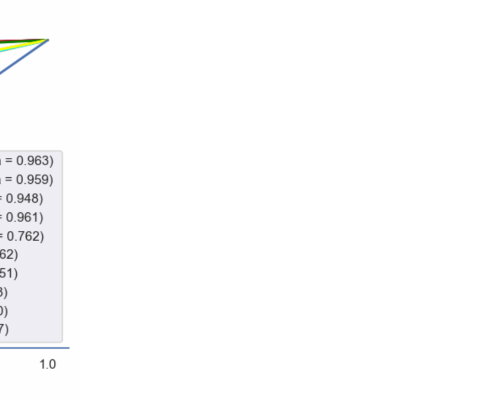
Figure 6. Receiver operating characteristic curves of the algorithms compared to the F-OE method.